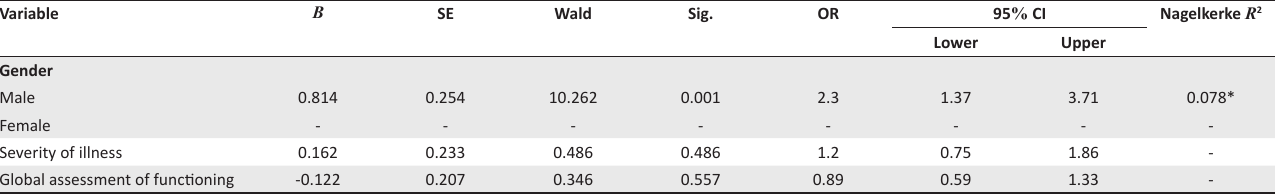
TABLE 4: Independent correlates of premorbid